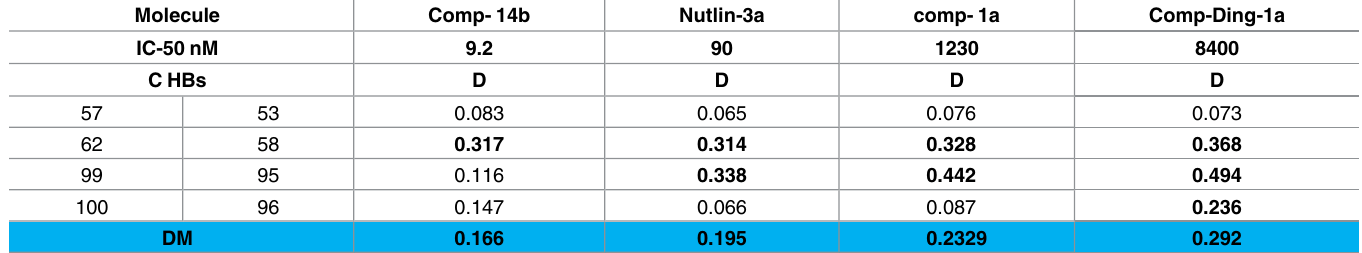
Table 4. DM values for different p53-MDM2 disruptive molecules. We consider the moleculescompound14-b [22], nutlin-3a [20], compound1-a [23] and compoundDING-1a [24]. For each of the MDM2 C-HBs (indicated by the pair of residues comprised in the HB) we calculate the D-values and, by aver- aging such quantities, we provide the DM-value for the